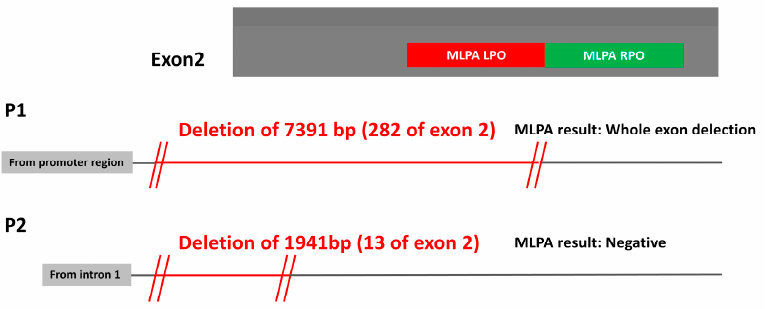
Figure 2. Representation of two SERPINC1 deletions affecting exon 2 not precisely identified by MLPA in two patients with antithrombin deficiency. The length of the deletion, the position of the MLPA probes and the results generated by this technique are indicated.